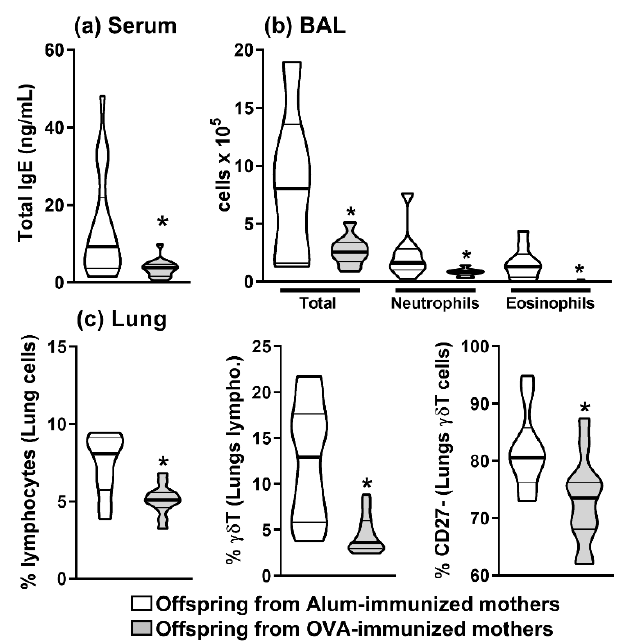
Figure 1. Induction of offspring allergy tolerance mediated by maternal immunization with OVA. Offspring from OVA-immunized ( n = 10) or Alum-immunized ( n = 11) mothers were immunized with OVA in the neonatal period. At 20 d.o., offspring total IgE was determined by ELISA ( a ). These groups were subjected to an allergic lung inflammation protocol with OVA, and differential cell counts in BAL ( b ) were evaluated by flow cytometry. The percentage of infiltrated lymphocytes, the frequency of γδT cells, and the frequency of CD27 - γδT cells was evaluated in the dissociated lung tissue ( c ) by flow cytometry. The results are illustrated with violin plot (truncated) representing median (bold line) and the quartiles (thin lines). * p ≤ 0.05 compared to Alum-immunized offspring.